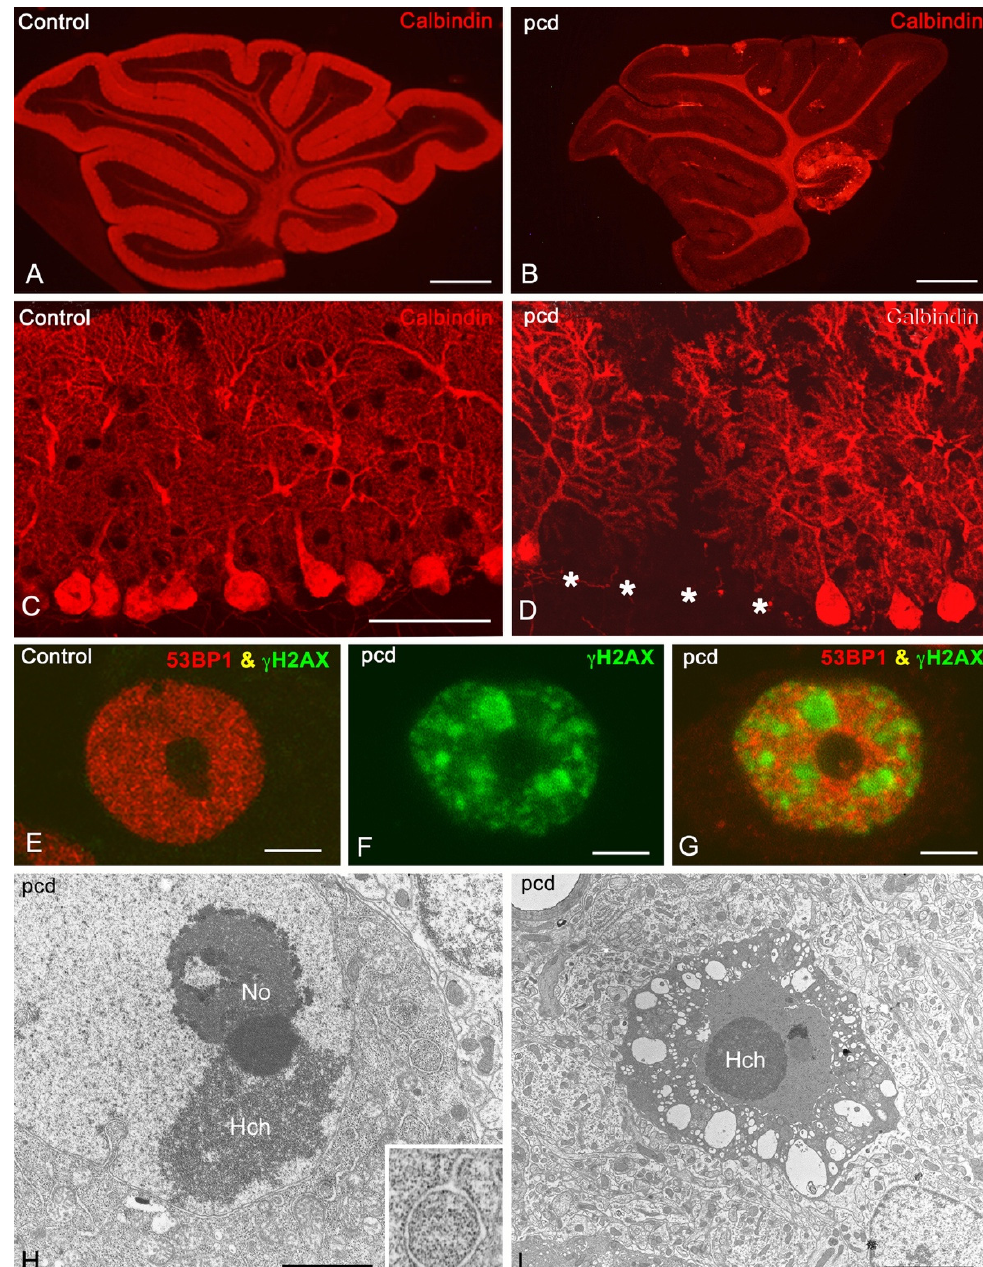
Figure 4. Degenerative features of the Purkinje cells in the pcd mice. ( A , B ) Representative confocal microscopy images of sagittal sections of the vermis of P30 control ( A ) and P30 ( B ) pcd mutant mice immunolabelled for calbindin D-28k. Note that in the pcd mouse there was a dramatic reduction in calbindin immunostaining in the molecular and PC layers resulting from the massive loss of PCs at P30 and that only PCs located in lobule X remained (arrow in B). Scale bars: 1 mm. ( C , D ) High magnification of calbindin D-28K immunolabelling of PC perikarya and their dendritic trees in control ( C ) and pcd mice ( D ) at P20. Note the loss of PCs (white asterisks) in the pcd mouse. Scale bar: 100 µ m. ( E–G ) Confocal microscopy images of PC nuclei from control ( E ) and pcd mice ( F , G ) at P20 double immunolabelled for the modified histone γ H2AX (green), a marker of DNA double-strand breaks at sites of DNA damage, and p53-binding protein 1 (P53BP1, red), a key DNA repair factor. ( E ) Note the absence of γ H2AX labelling and the typical diffuse nucleoplasmic distribution of 53BP1, in the control PC nucleus, excluding the nucleolus. ( F , G ) In contrast, the nucleus of the pcd mouse shows prominent nuclear foci of DNA damage immunostained for γ H2AX ( F ). Although the DNA repair factor 53BP1 was expressed in the nucleoplasm, it was not concentrated in γ H2AX-positive nuclear foci of DNA lesions ( G ), indicating defective DNA repair. Scale bars: 5 µ m. ( H )